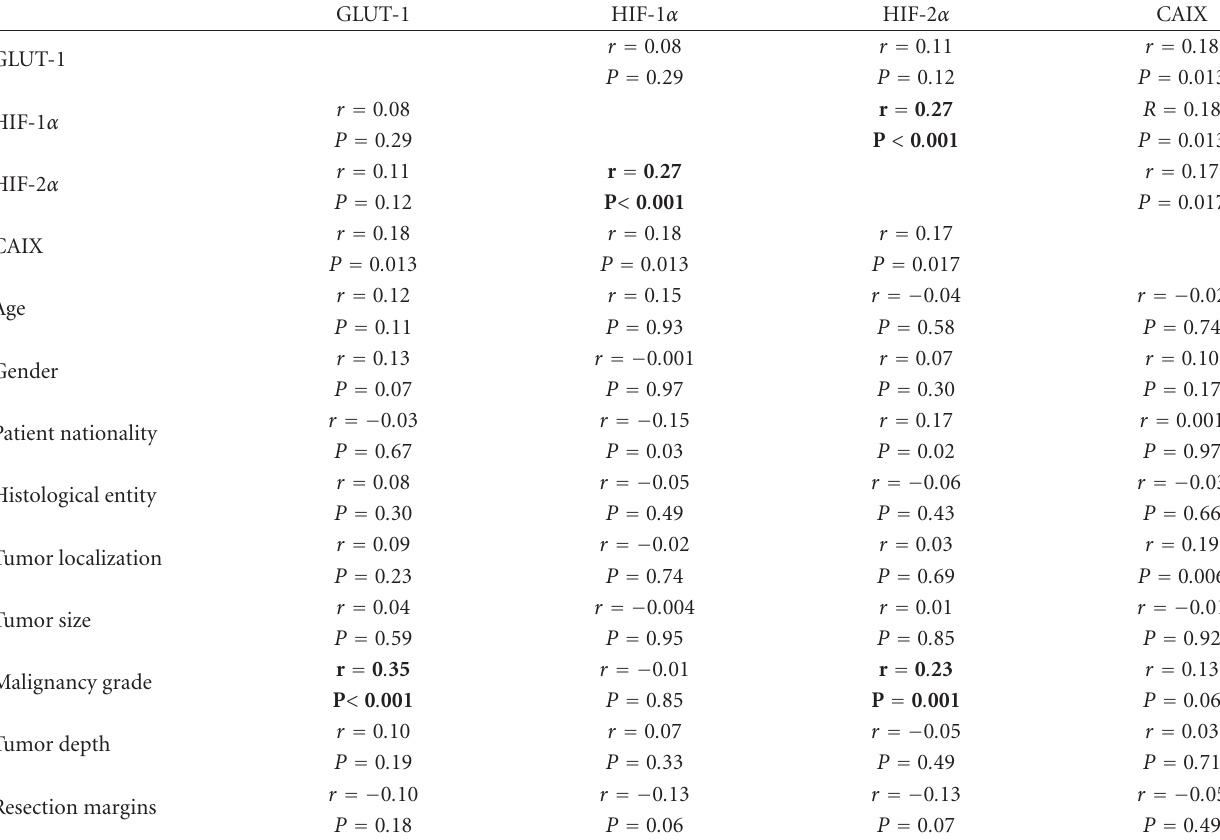
Table 2: Correlation between expression of hypoxic markers and clinicopathological variables. GLUT-1